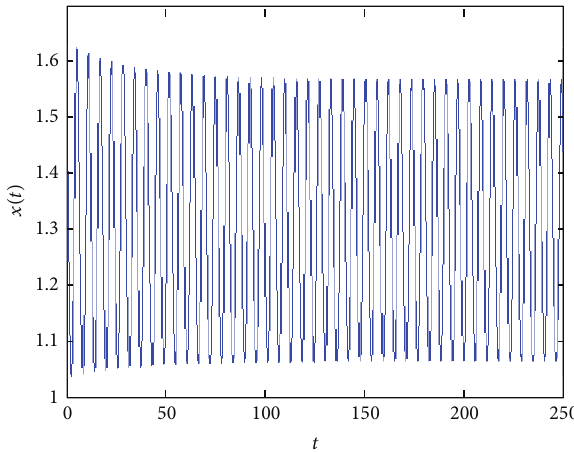
Figure 2: Trajectory that converges to the steady-state equilibrium.